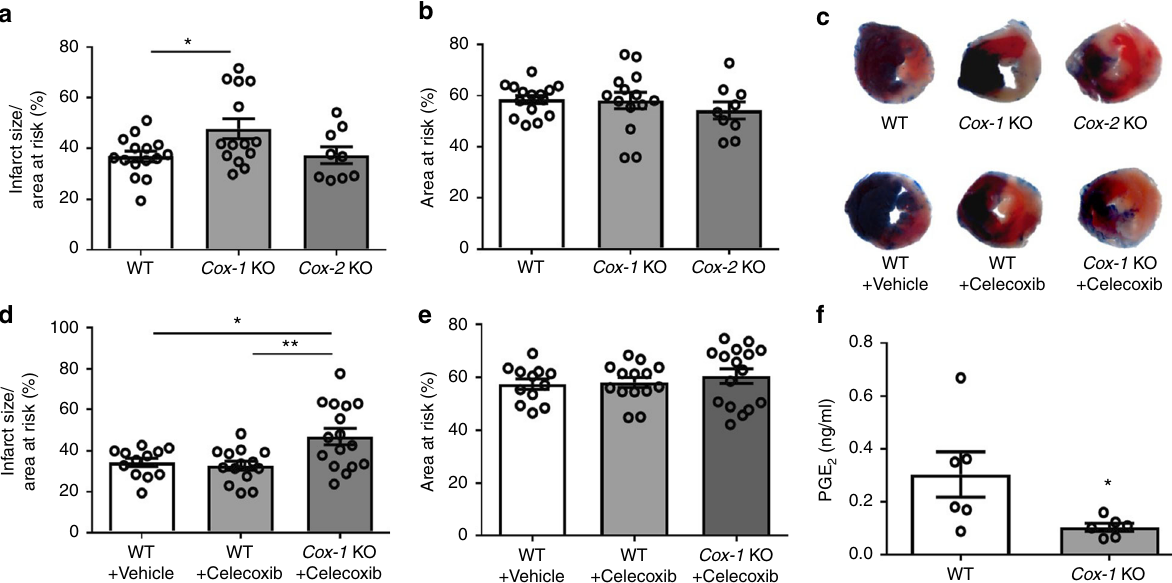
Fig. 1 Impact of Cox-1/2 deletion on MI/R injury. Infarct size (IS) ( a ) and area at risk (AAR) ( b ) were quanti fi ed 24 h after I/R injury, as detailed in the Methods. Representative photographs showing TTC stained transverse sections of Evans blue perfused hearts were shown for each study group ( c ). In a separate study, mice were orally treated with 100 mg/kg celecoxib or vehicle before and 20 h after surgery. Representative TTC staining of the heart sections was shown for each group ( c ), and their infarct size ( d ) and AAR ( e ) were quanti fi ed. Biosynthesis of PGE 2 ( f ) was measured by HPLC-MS-MS as detailed in the Methods. One-way ANOVA with Tukey ’ s multiple comparison test ( a , b , n = 15, 14, 9; d , e , n = 12, 14, 16. Individual n numbers in each panel are shown in same order as their corresponding groups from left to right, and this arrangement is applied to other relevant fi gures in the text.). Unpaired Student ’ s t test ( f , n = 6). Statistical signi fi cance is demarked as * P < 0.05, ** P < 0.01, and *** P < 0.001, throughout the text. Error bar indicates